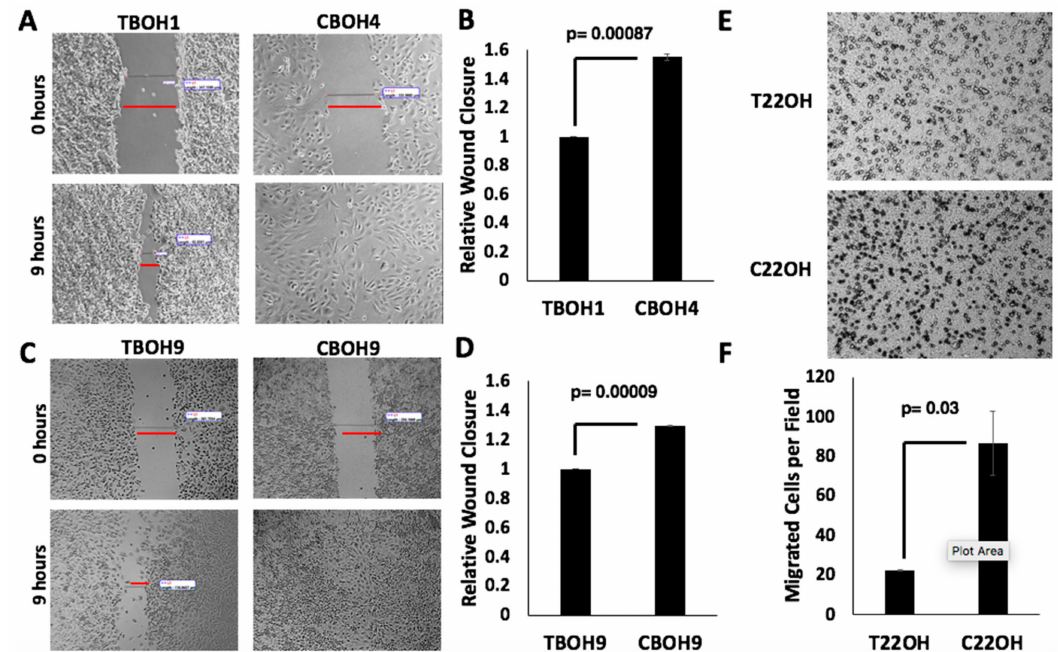
Figure 3. CTCs have greater migratory capacity than cancer cells from primary tumors. ( A , C ) Wound healing migration assays were performed on HCC cell lines. Cells were grown in 6-well plates. When confluent, wounds were made and measured at 0 and 9 h intervals. Wound closure by CTCs, but not by primary tumor-derived cell lines, was complete by 9 h. Images were taken at 10 × magnification using Motic AE30 imaging software. ( B , D ) Migration (wound closure) was quantified; N = 3. ( E ) Transwell migration assays were performed on CRPC primary tumor-derived cell lines and CTC lines. Cells that migrated successfully through the pore membrane are represented by dark spots. Images shown were taken at 20 × magnification. ( F ) Migration was quantified. Data provided on graphs are presented as mean ± standard error of the mean (SEM); N =